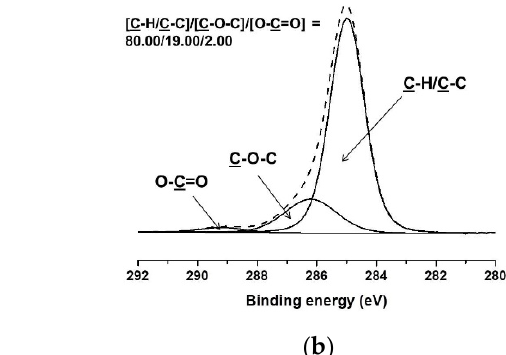
PEO(50)/PLA(25)/BW(25) mats resulted in an increased proportion of carbon atoms en- gaged in the C-H/C-C group, and again the experimentally estimated [C-H/C-C]/[C-O- C]/[O-C=O] ratio (Figure 5B) was higher than the theoretical value (32.00/59.00/9.00). The obtained XPS results revealed that the surface chemical composition of PEO/PLA/BW fi- brous materials approximated BW composition. This is additional evidence that the outer sheath of the fibers consists of BW. The obtaining of PEO/PLA/BW fibers with core/double-sheath structure can be at- tributed to the occurrence of spontaneous phase separation of the partners during the electrospinning, driven by the significant differences in the molar masses of PEO, PLA and BW, the incompatibility of the partners, as well as by the air hydrophobicity. PEO has the highest molar mass (M η = 600,000 g/mol), PLA has lower molar mass (M w = 259,000 g/mol) and BW is composed of low-molecular-weight substances. We assumed that under the action of the electric field during the electrospinning process, BW as a complex mixture of low-molecular-weight substances would most easily migrate to the surface of the spin- ning jet and, accordingly, to the surface of the resulting fibers. The presence of an inner shell of PLA was most likely due to the lower molar mass of this polymer compared to PEO. Therefore, PLA more easily migrated to the surface of the polymer jet, but had more difficultly compared to BW. Most probably, BW assisted in obtaining the inner PLA sheath of the fibers. The hypothesis that a small fraction of PLA could be located in the PEO core, as well as a small fraction of PEO in the PLA inner sheath, should not be excluded. With respect to BW, the presence of traces of it in the core and inner sheath is also possible. The thermal characteristics of PEO/PLA/BW fibrous materials were evaluated by DSC. DSC thermograms of the mats are presented in Figure 6.